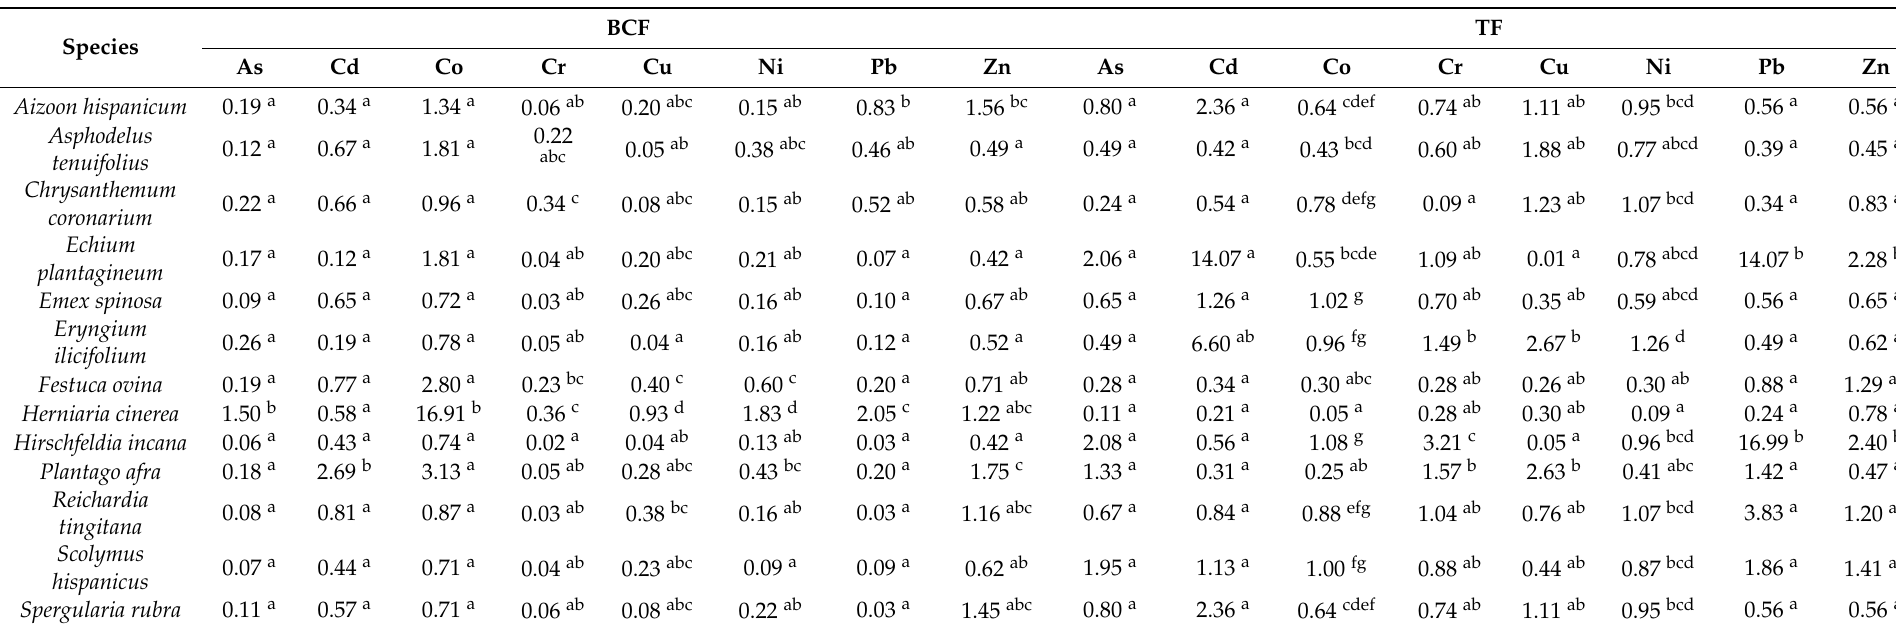
Table 5. Bioconcentration factor (BCF) and translocation factor (TF) of trace elements in the sampled species from the phosphate wastes cover.